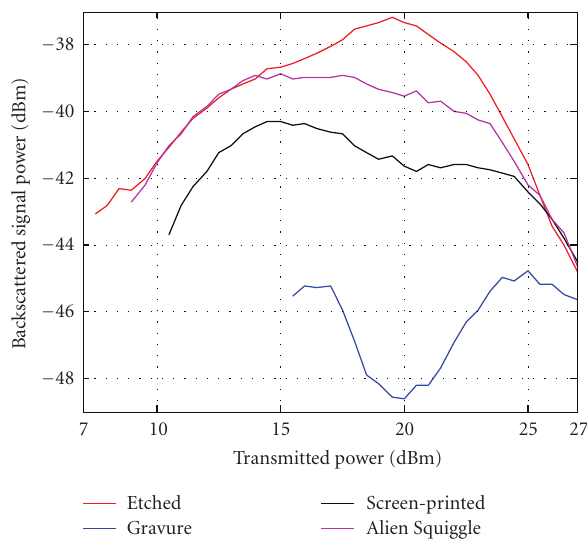
Figure 9: Measured backscattered signal power versus transmitted power at 866